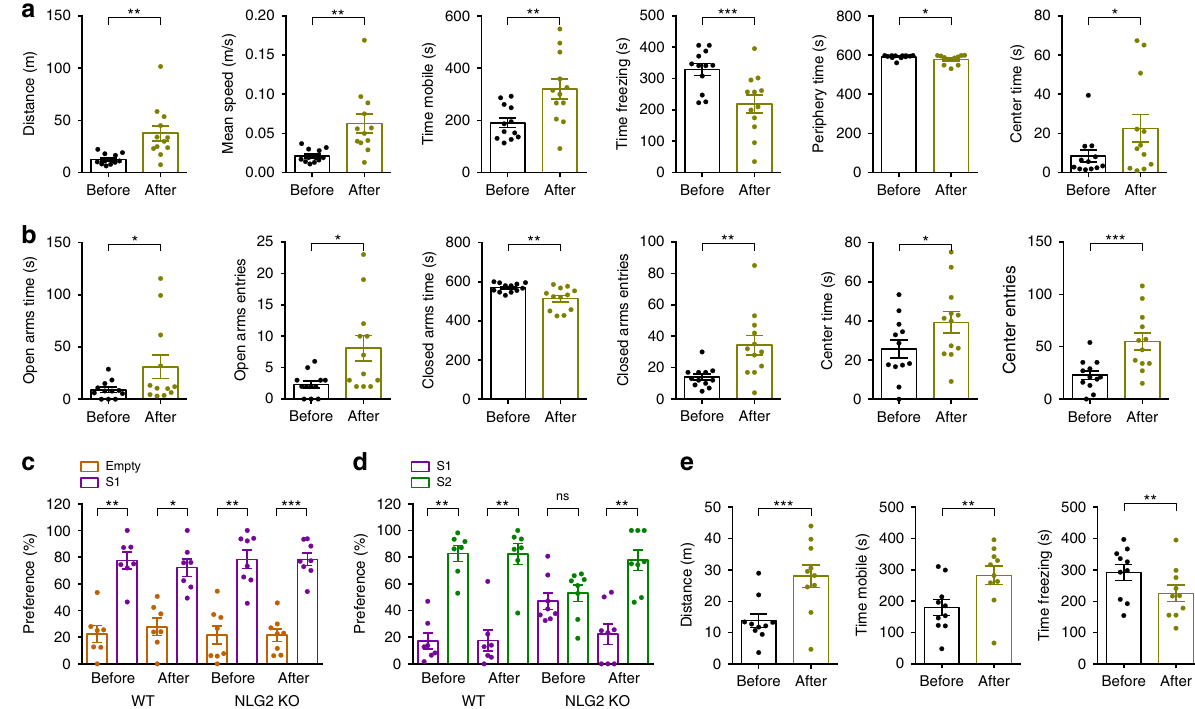
Fig. 5 ETX ameliorates behavior de fi cits in NLG2 KO mice. a Open fi eld test showing increased travel distance ( p = 0.0022), increased travel speed ( p = 0.0022), increased mobile time ( p = 0.001), decreased freezing time ( p = 0.0005), decreased time spent in periphery zone ( p = 0.0165), and increased time spent in center zone ( p = 0.0207) after systemic injections of ETX compared to before injections in NLG2 KO mice ( n = 12). b Elevated plus maze test showing increased time spent in open arms ( p = 0.0484), increased open arm entries ( p = 0.0100), decreased time spent in closed arms ( p = 0.0055), increased closed arm entries ( p = 0.0036), increased time spent in center ( p = 0.0172), and increased center entries ( p = 0.0007) after systemic injections of ETX compared to before injections in NLG2 KO mice ( n = 12). c Three-chamber social interaction test showing normal preference for S1 over empty cage during stage 2 after systemic injections of ETX in NLG2 KO mice (before treatment: p = 0.0045, after treatment: p = 0.0005, n = 8). d Rescue of preference for S2 over S1 during stage 3 of the three-chamber social interaction test by ETX treatment in NLG2 KO mice (before treatment: p = 0.6516; after treatment: p = 0.0084) in NLG2 KO mice ( n = 8). e Open fi eld test showing increased travel distance ( p = 0.0005), increased mobile time ( p = 0.0037), and decreased freezing time ( p = 0.008) after local injections of ETX to the thalamus in NLG2 KO mice (n = 10). Data in a – e represent mean